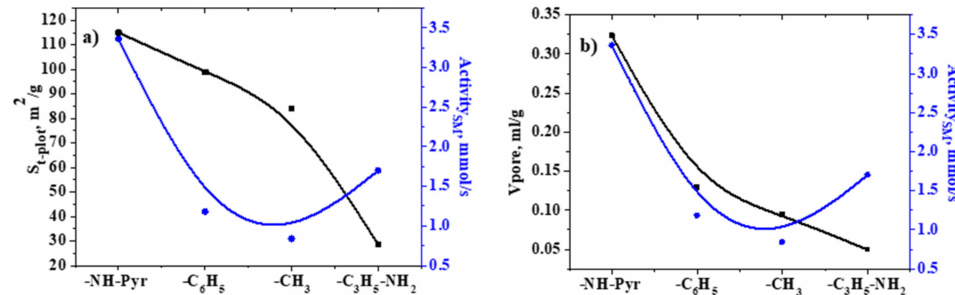
Figure 12. The relationship between the activity of deposited palladium in hydrogenation of sodium maleate and ( a ) the specific surface area of their supports, ( b ) the nature of functional groups.